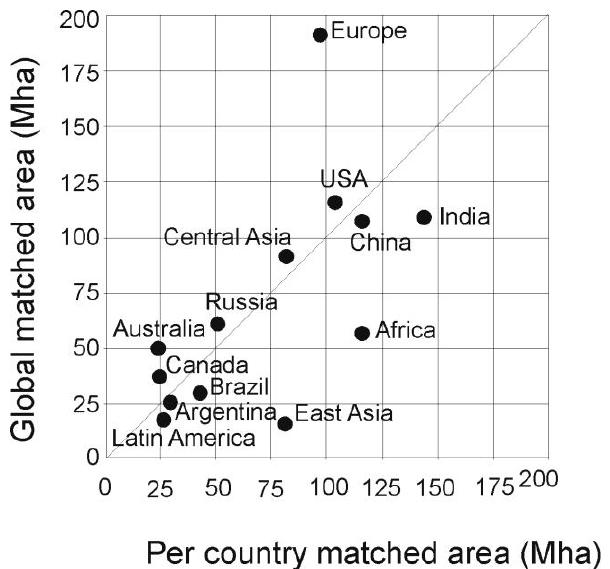
Figure 1. Comparison of country/regional estimates of cropland extent derived from a single global matching threshold versus per country matching